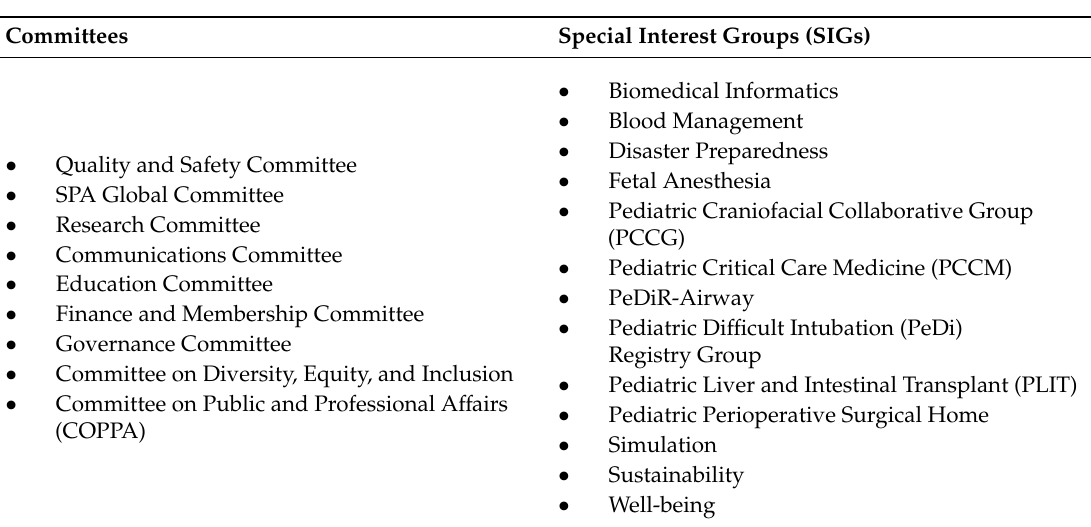
Table 4. SPA committees and special interest groups